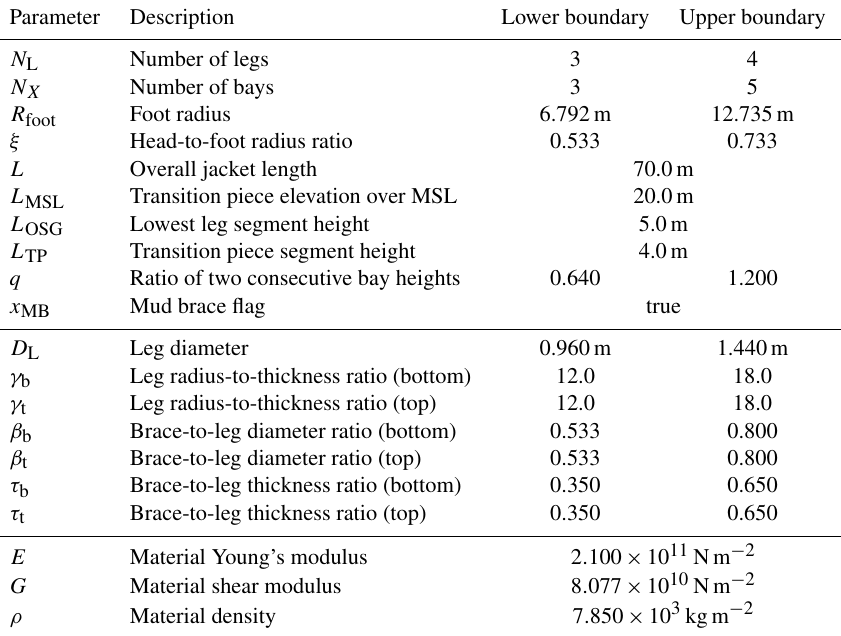
Table 1. Jacket model parameter boundaries for the design of experiments. Topological, tube sizing, and material parameters are separated in groups; single values indicate that the corresponding value is held constant.